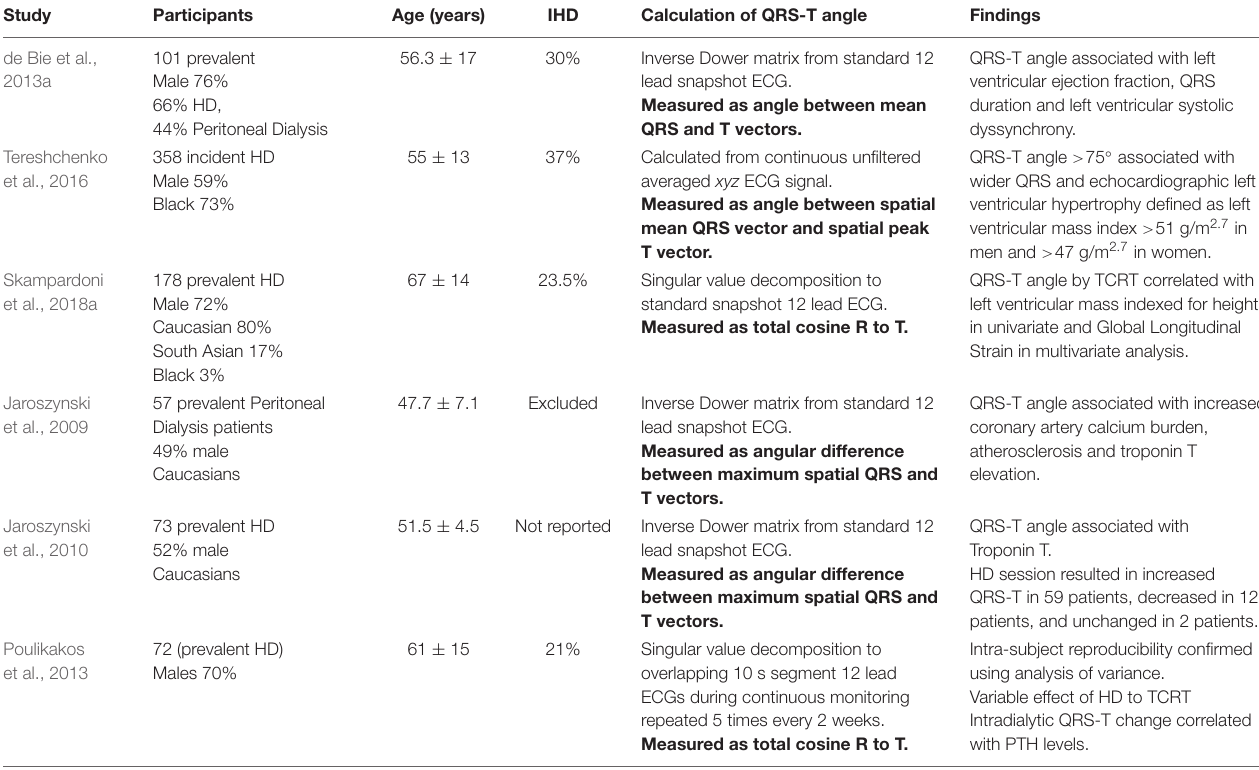
TABLE 4 | Studies of QRS-T angle reporting on associations with cardiovascular parameters and dialysis